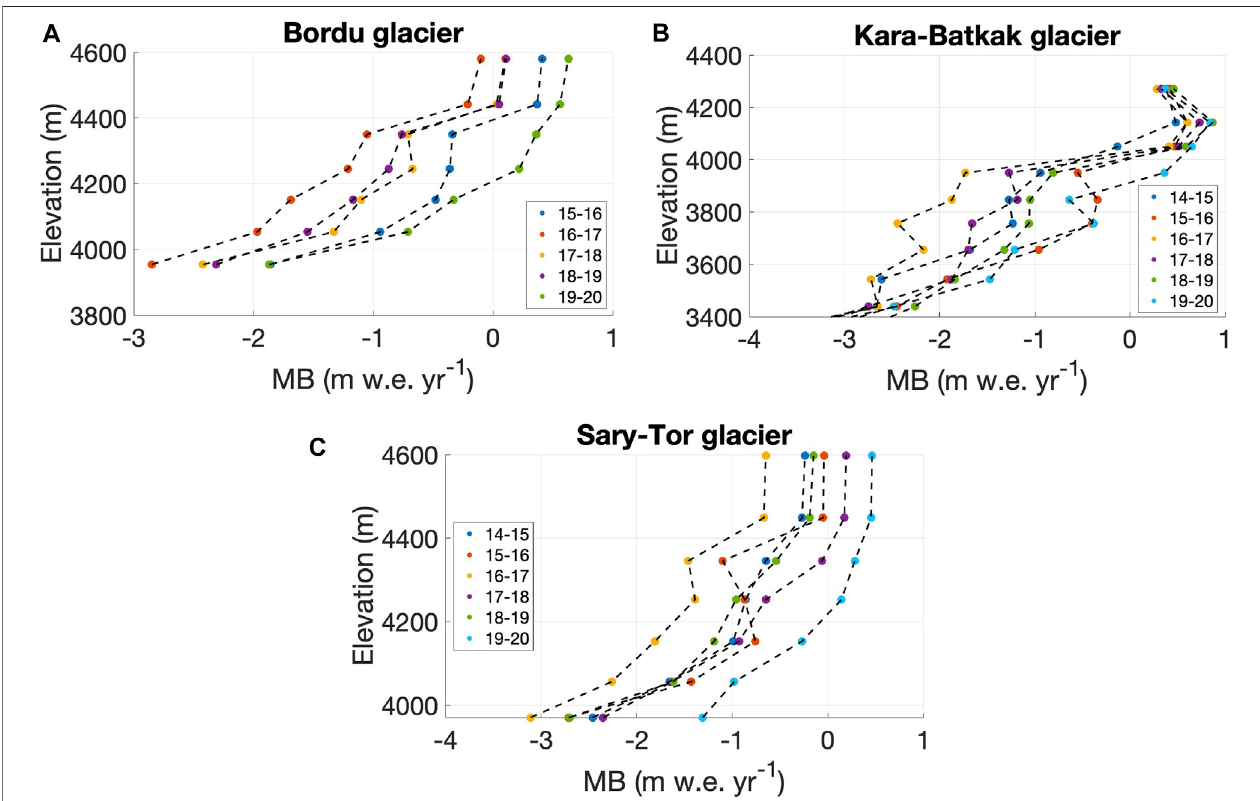
FIGURE2| Massbalance(MB) pro fi les ofthedifferentyears covered since there-initiation ofthe measurements onthe glaciers considered inthis study, averaged in bands of 100 m. Data are retrieved from the WGMS (2020).